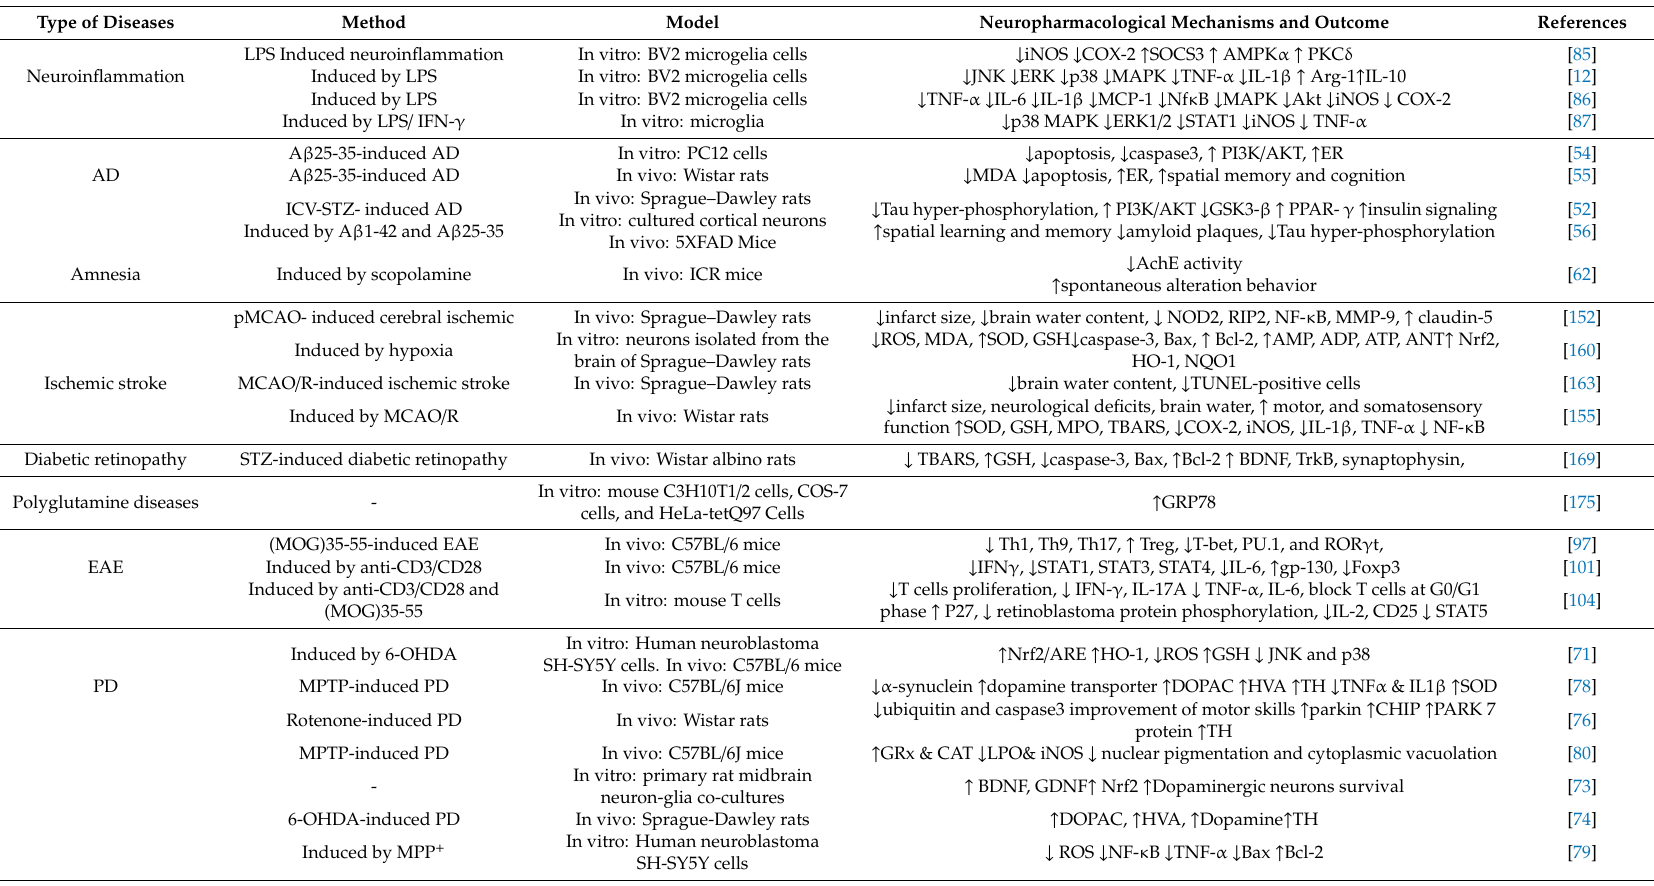
Table 1. Neuropharmacological mechanisms of naringenin against di ff erent type of neurodegenerative